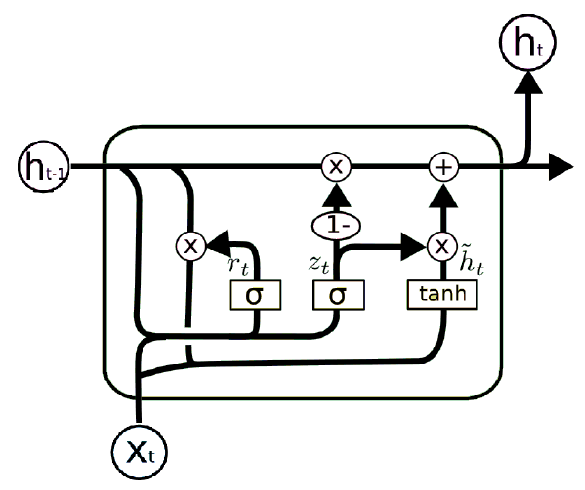
Figure 2. A gated recurrent unit.